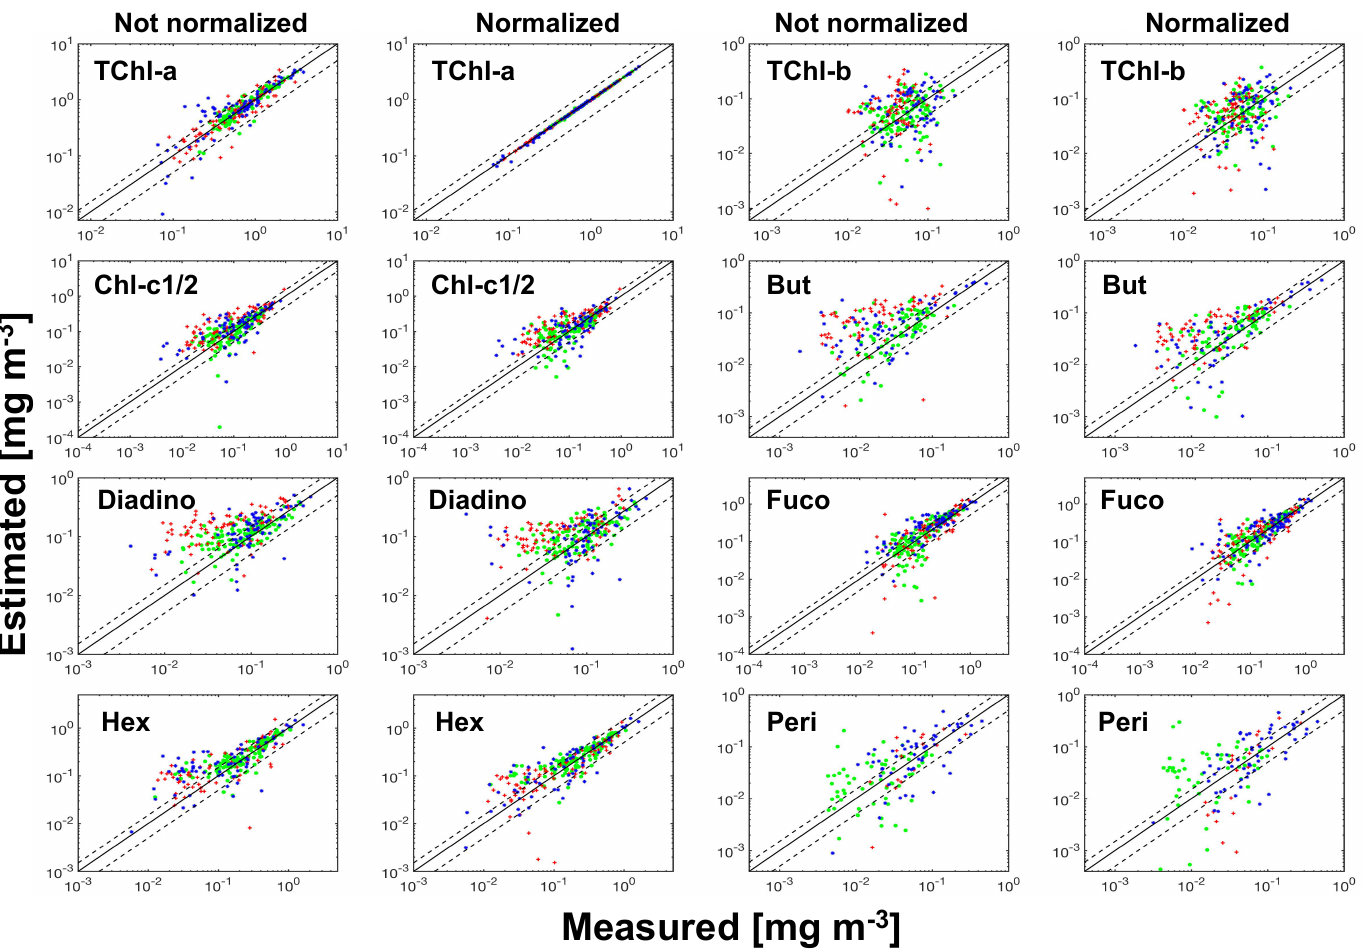
Figure 8. Scatter plots of SVD-NNLS-9 estimated pigment concentrations versus measured pigment concentrations for unperturbed training data set. The symbols of green circles, red crosses and blue stars represent the data from the cruises PS93.2, PS99.2 and PS107, respectively. Dash lines denote the 50% error lines, and solid lines are one-to-one